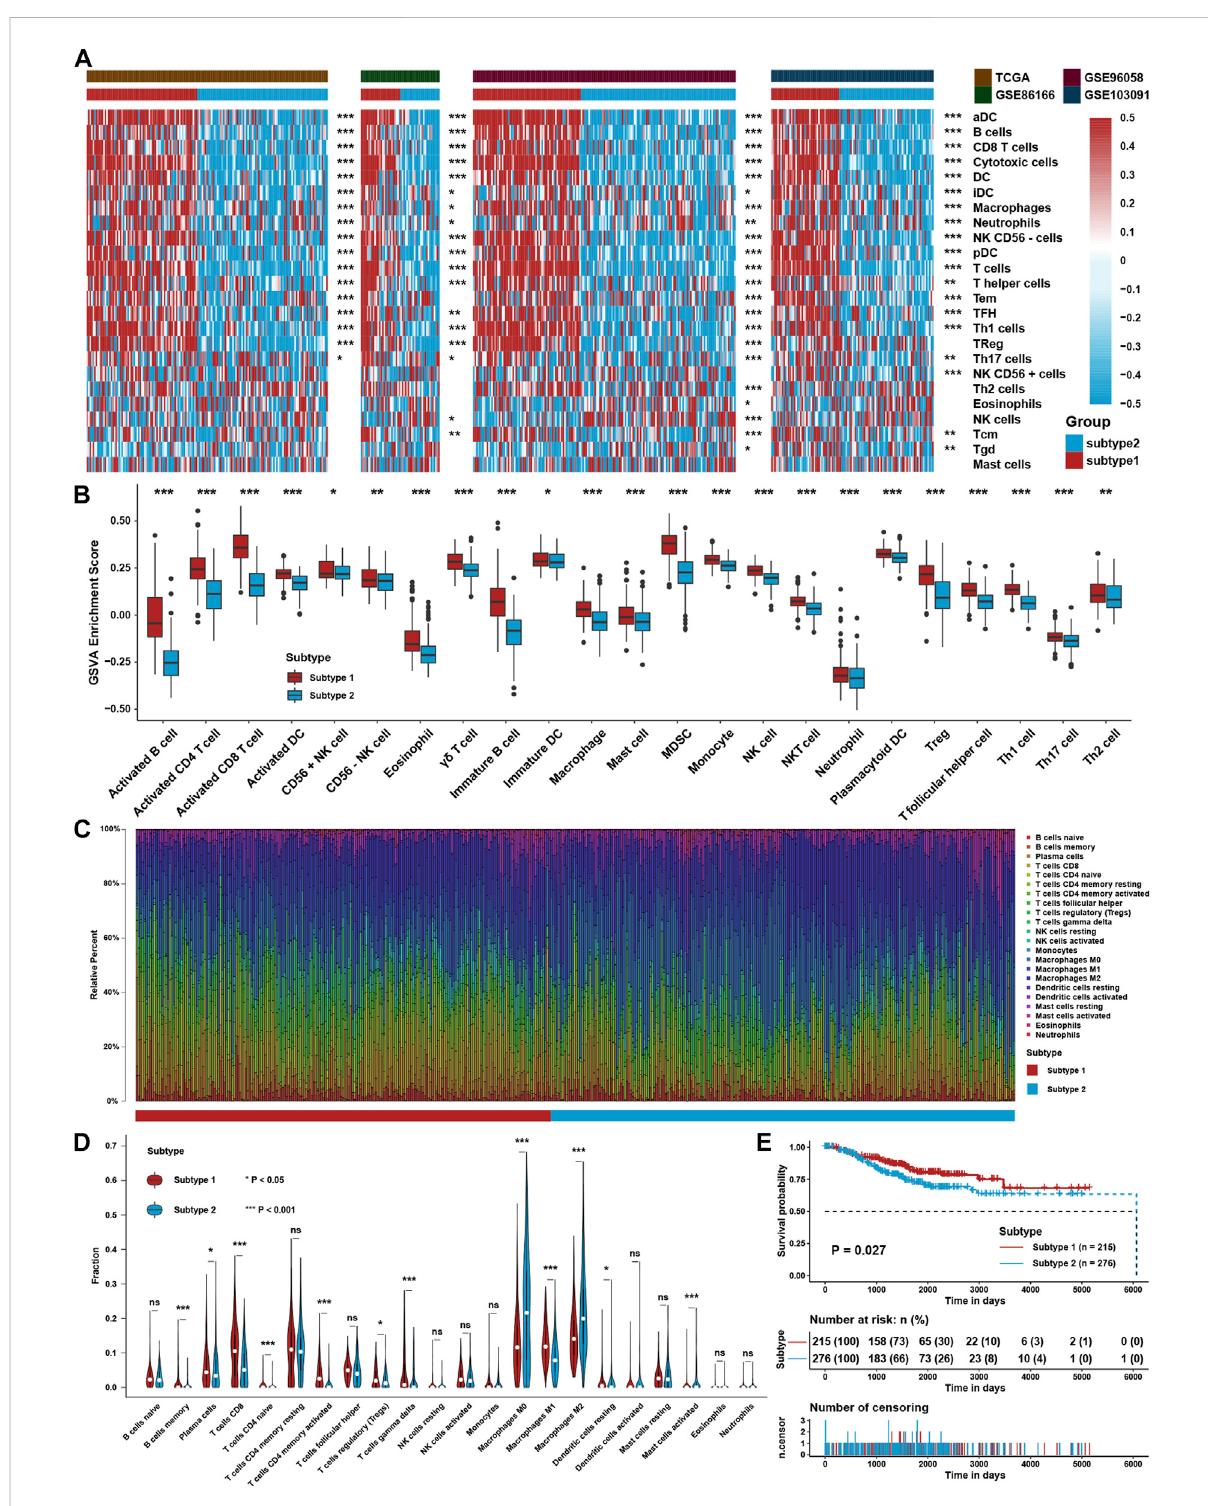
FIGURE 2 Identi fi cation of TME Subtypes. (A) Clustering heatmap of immune cell in fi ltration levels calculated with immune cell signature 1 in four TNBC cohorts. (B) Immune cell in fi ltration levels were calculated with immune cell signature 2 in the TNBC cohort between the two TME subtypes. (C) CIBERSORTalgorithmassessedtherelativepercentageofdifferentimmunecelltypesinasinglesampleinthewholeTNBCcohort. (D) Differencesin immune cell type relative percentages assessed by the CIBERSORT algorithm in a single sample in the whole TNBC cohort. (E) Survival analysis for TME subtypes in the whole TNBC cohort. The asterisks represent the statistical p value (* p < 0.05; ** p < 0.01; *** p <